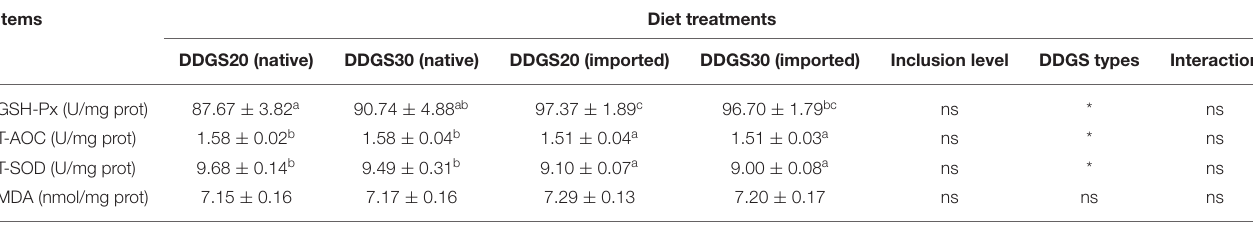
TABLE 6 | The effects of different types and levels of dietary DDGS on the hepatic antioxidant indices of juvenile grass carp a . Items